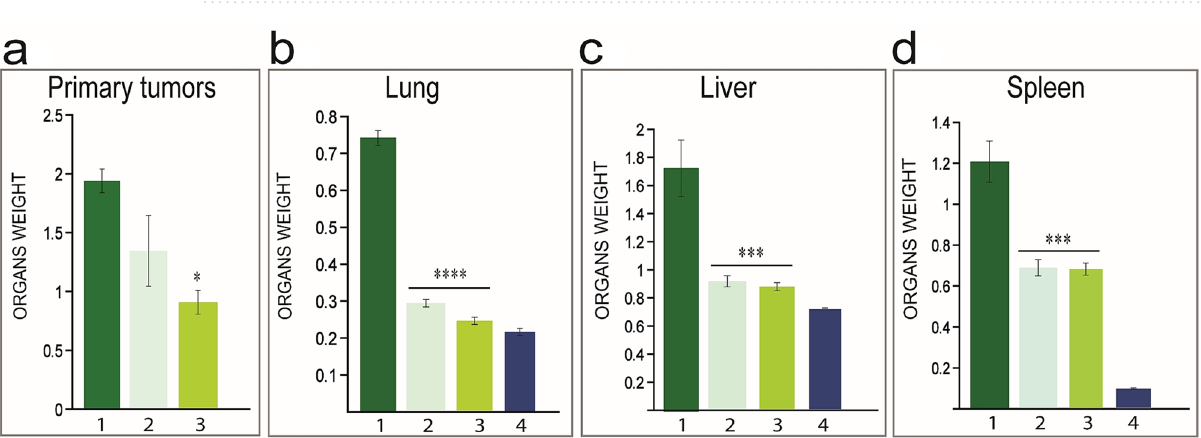
Figure 4. Organs weight. A . Primary tumours. B . Lungs. C . Liver D . Spleen. 1. tumour bearing mice untreated with CD-NHF; 2. tumour bearing mice treated with 10% CD-NHF; 3. tumour bearing mice treated with 20% CD-NHF; 4. Organs from tumour free mice . *p < 0.05, ***p < 0.0005,****p <